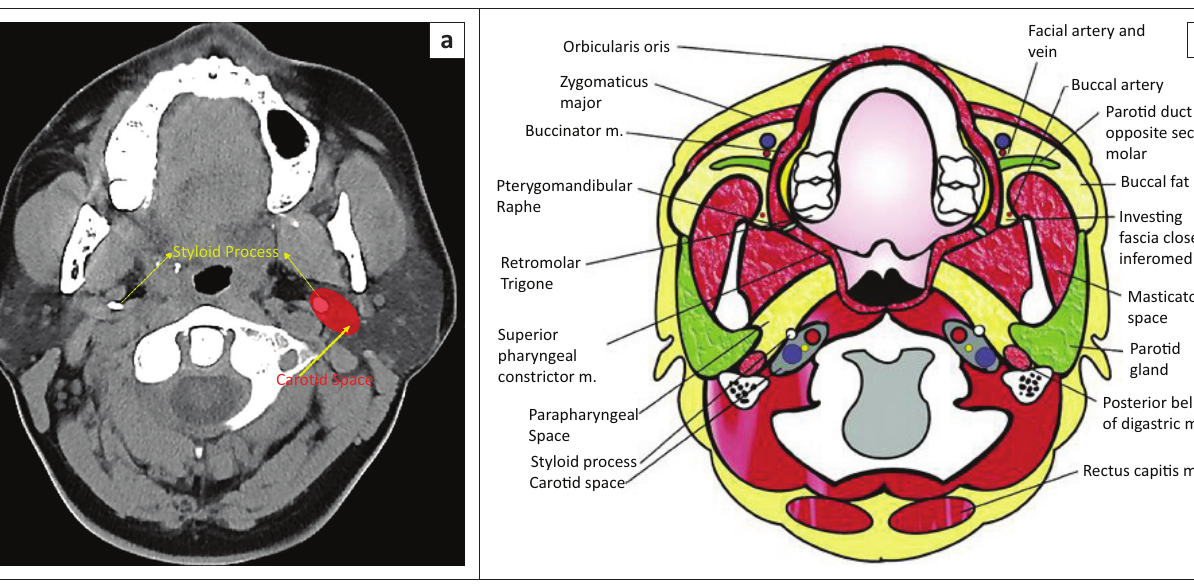
FIGURE 5: (a) CT-axial view representing styloid process and associated carotid space, and (b) schematic